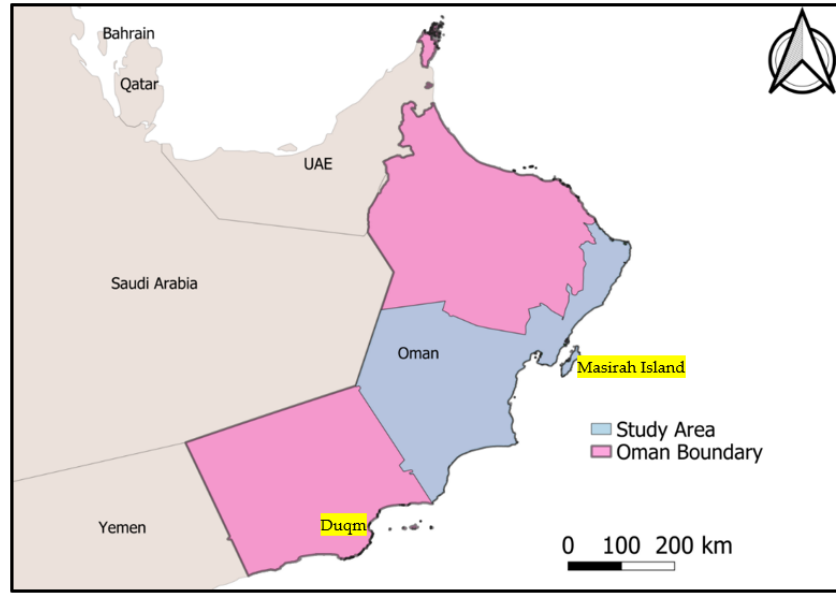
Figure 1. Boundary of the study area.